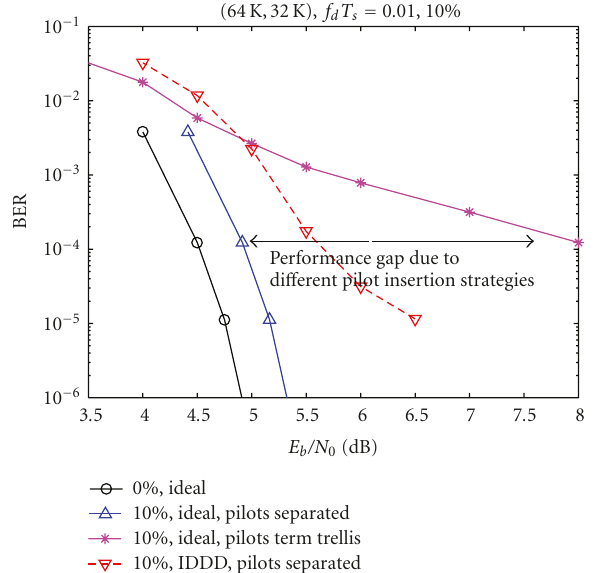
Figure 10: Performance of PA codes with di ff erent pilot insertion strategies. Normalized Doppler rate f d T s = 0 . 01, code rate 0.5, data block size 32 K, 0% or 10% pilot insertion, 10